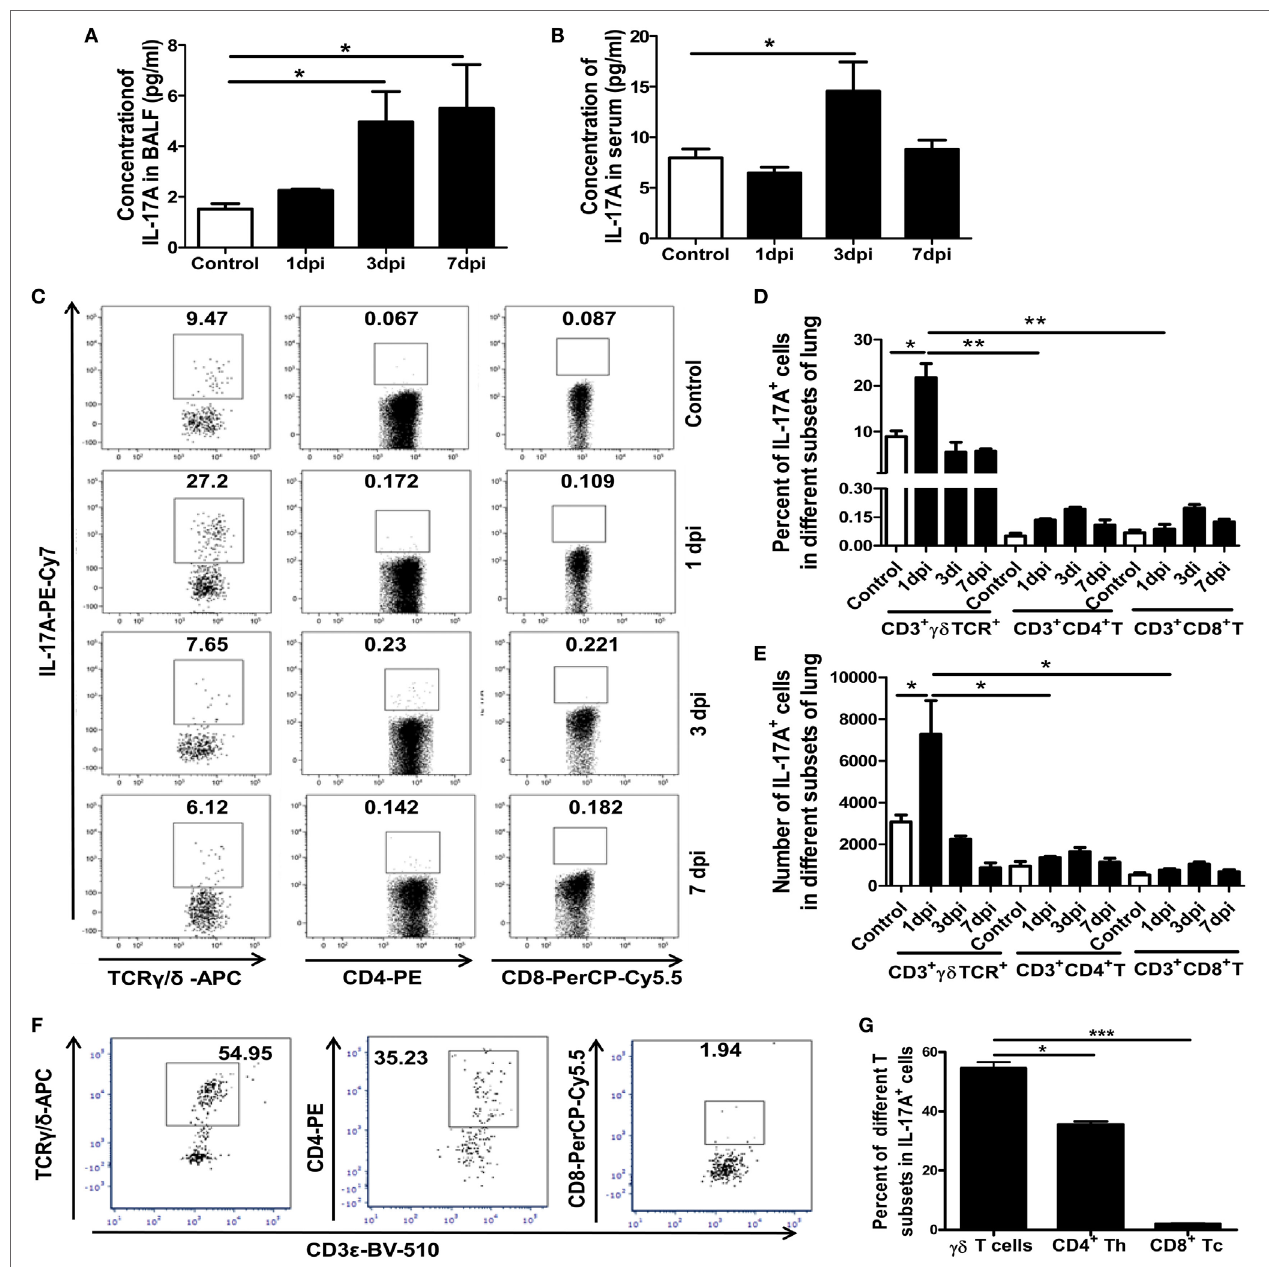
FigUre 2 | Concentrations of IL-17A in BALF and serum, and proportion and number of γδ T17, Th17, and Tc17 cells at different dpi. IL-17A concentrations in BALF (a) and serum (B) of the control or infected mice at the indicated dpi were quantified using ELISA. (c) Expression of IL-17A among CD3 + TCR γδ + , CD3 + TCR αβ + CD4 + Th, and CD3 + TCR αβ + CD8 + Tc subsets in the control and infected lungs at the indicated dpi. The numbers represent the proportion of IL-17A- positive cells among different subsets at the indicated dpi. Histogram showing the changes in the proportion (D) and number (e) of γδ T17, Th17, and Tc17 cells